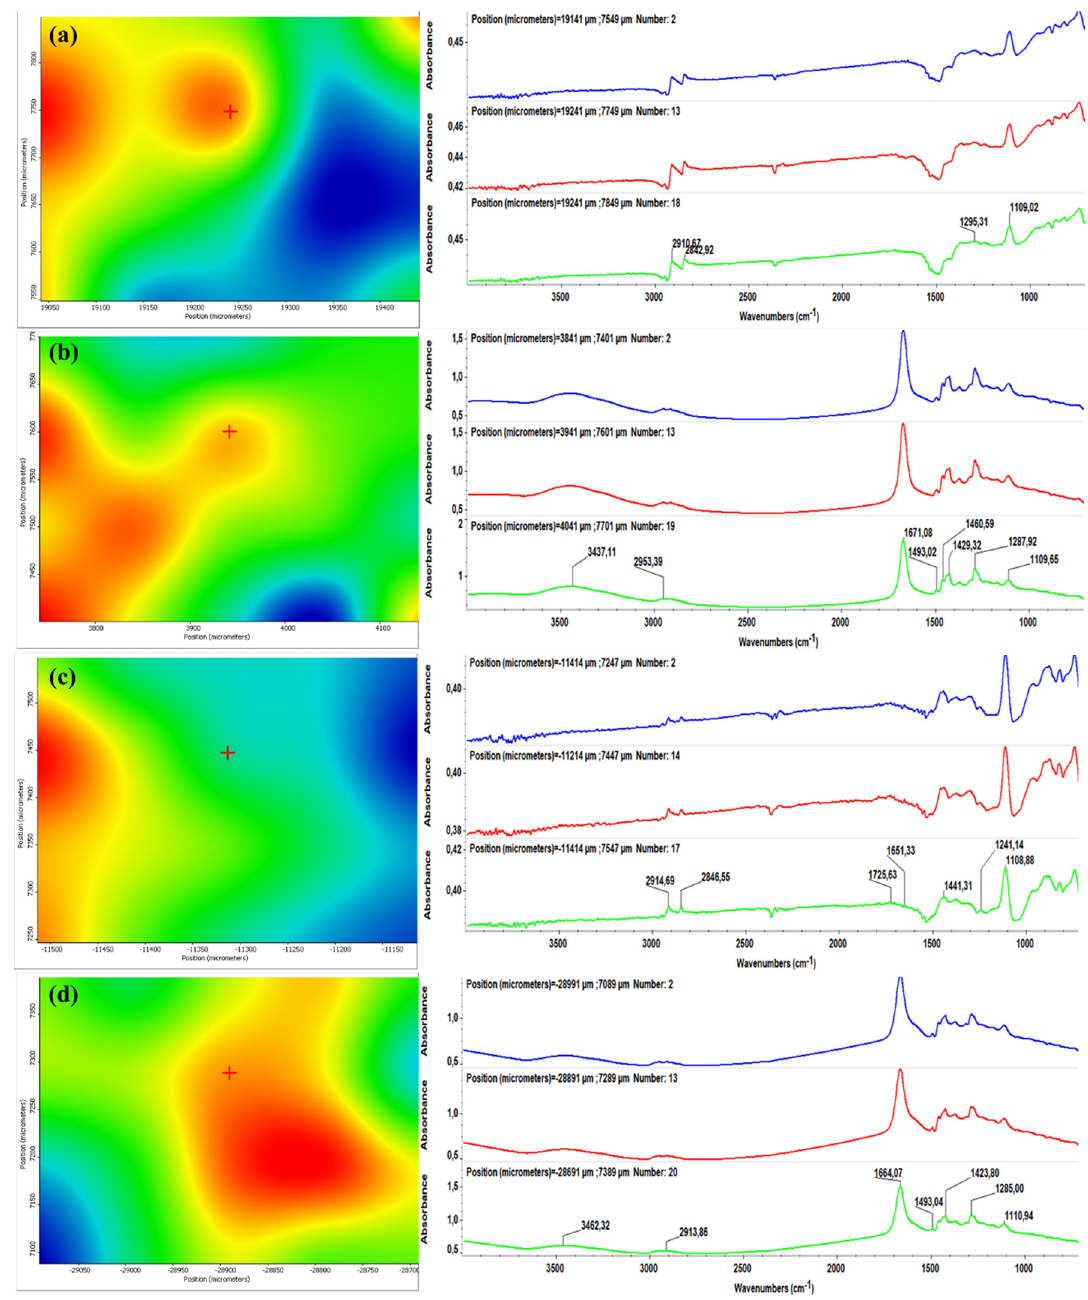
Figure 5. Second derivate IR mappings (left) and FT-IR spectra (right) of ( a ) PVP/FL drop-cast, ( b ) PVP/FL thin films deposited at 200 mJ/cm 2 laser fluence, ( c ) PVP/FW drop-cast, and ( d ) PVP/FW thin films deposited at 200 mJ/cm 2 laser